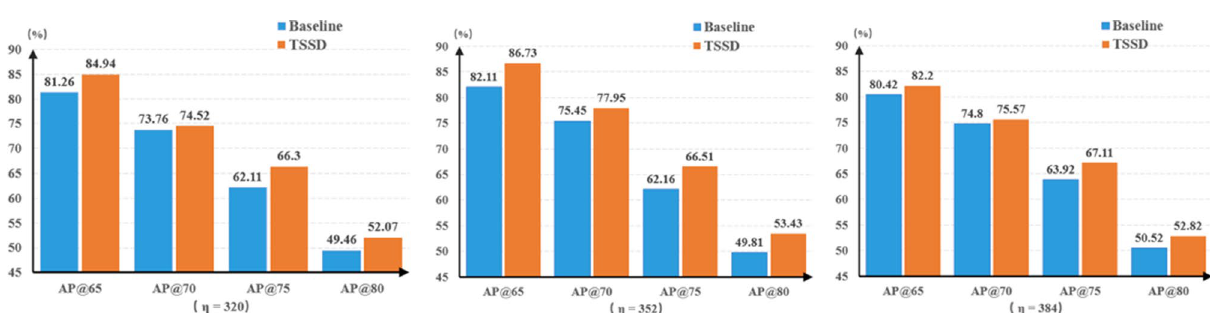
Figure 9. Comparison of accuracy between TSSD algorithm and the baseline model at different γ values.